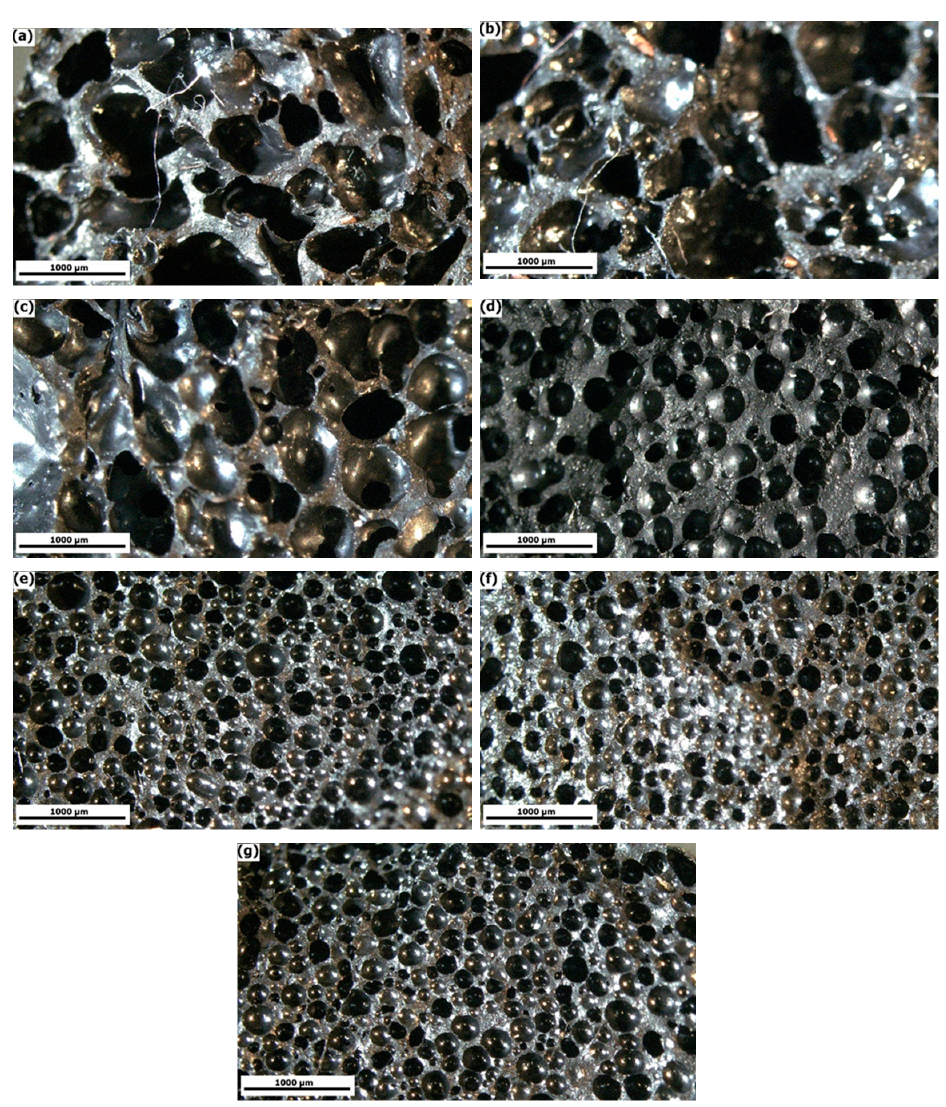
Figure 2. Cell morphology of NR/CNT/GNS nanocomposite foams with different CNT/GNS hybrid content: ( a ) 0 phr, ( b ) 0.1 phr, ( c ) 0.25 phr, ( d ) 0.5 phr, ( e ) 1 phr, ( f ) 1.5 phr, and ( g ) 2